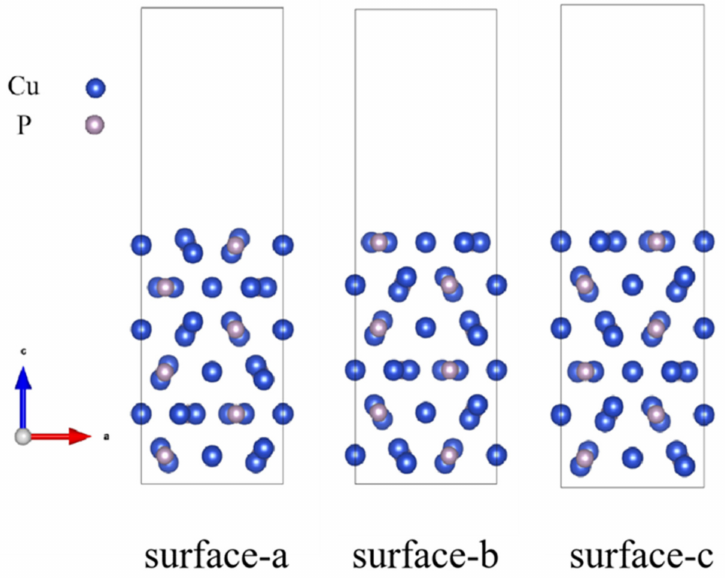
Figure 1. Three different terminations for the Cu 3 P (100)